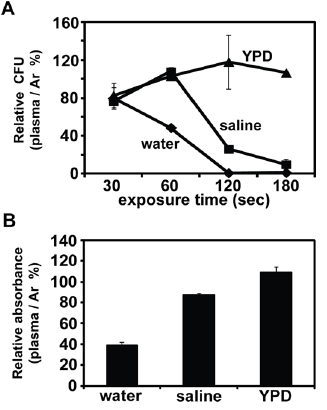
Figure 1. Viability of yeast cells measured by colony formation and MTT assay after plasma treatment. ( A ) Relative percentage of colony formations by yeast cells in water, saline, and YPD after treatment with plasma, compared to Ar gas only. Relative colony forming units (CFU) are calculated as follows: relative CFU (%)=(CFU number of plasma treated yeast/CFU number of Ar gas treated yeast) 6 100. All value are the average of three technical replicates. ( B ) The relative level of formazan product measured as absorbance at 490 nm in cells treated with plasma in water, saline, and YPD, compared to that in Ar gas treated cells. Yeast cells were treated with plasma and Ar gas for 3 min. Relative absorbance was calculated as relative absorbance (%)=(absorbance at 490 nm in plasma treated cells/ absorbance at 490 nm in Ar gas treated cells) 6 100. Each value is the average of three technical